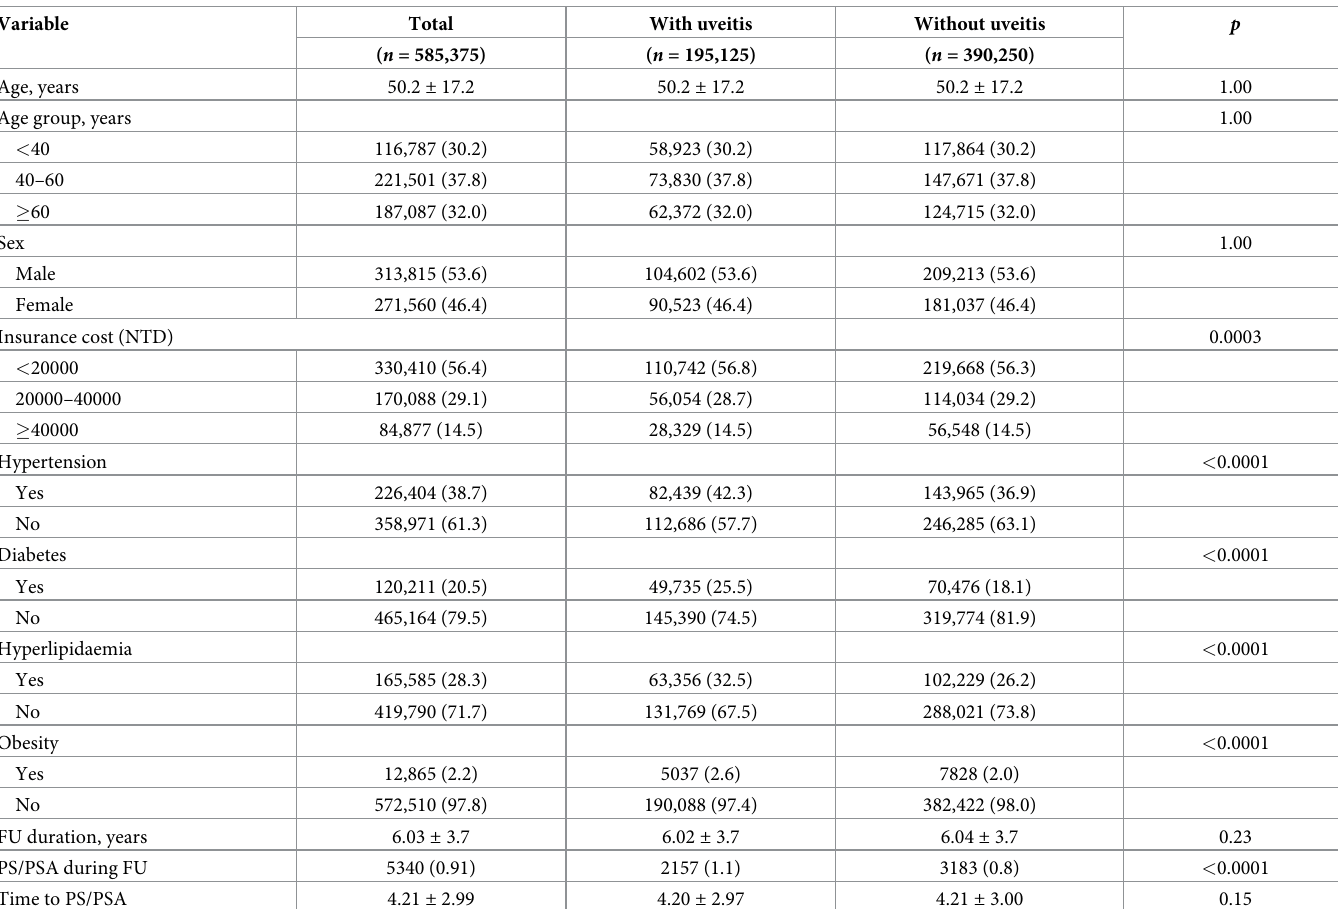
Table 1. Characteristics of the study